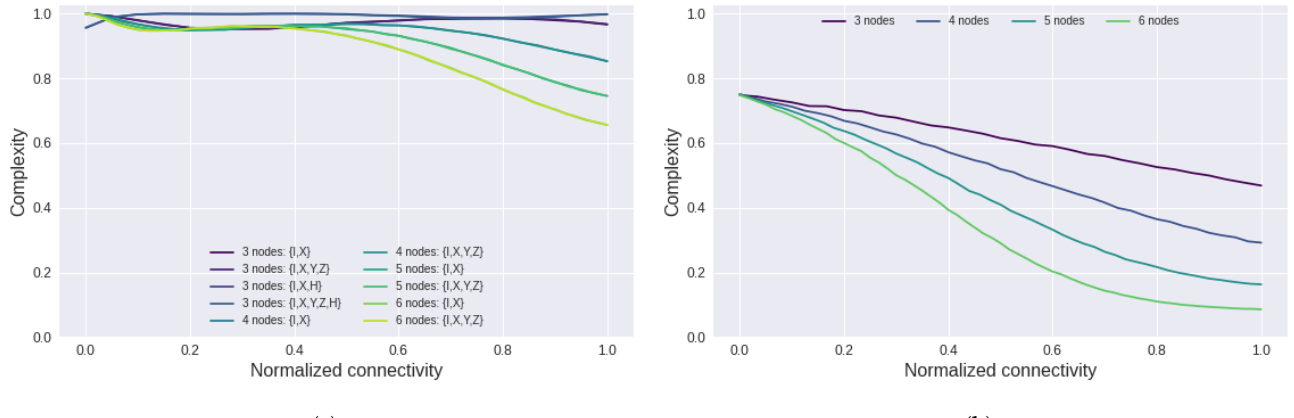
Figure 5. Panel ( a ) shows the complexity for different QBN configurations. Connectivity was normalized to allow a direct comparison between networks of different sizes. Panel ( b ) show the complexity for RevBNs of different sizes. A detailed version of the complexity for QBNs and RevBNs can be consulted in Figures A5 and A6,